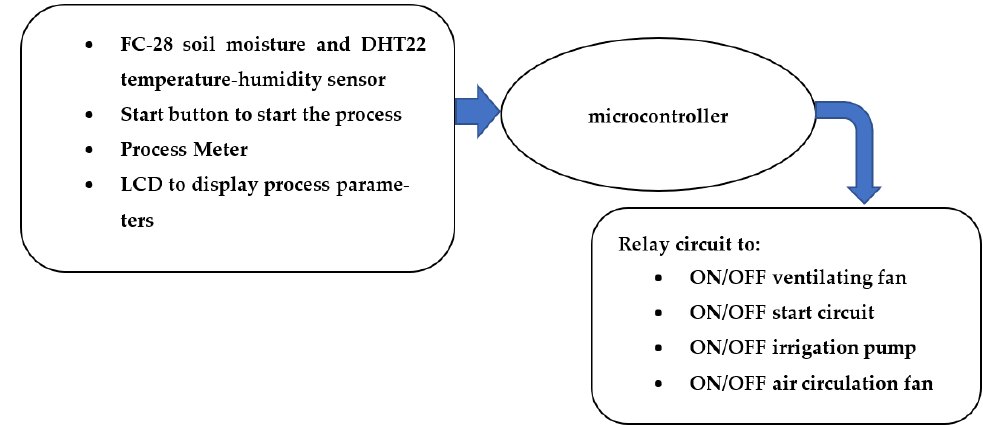
Figure 3. Input and output pin connections for the Arduino microcontroller system.